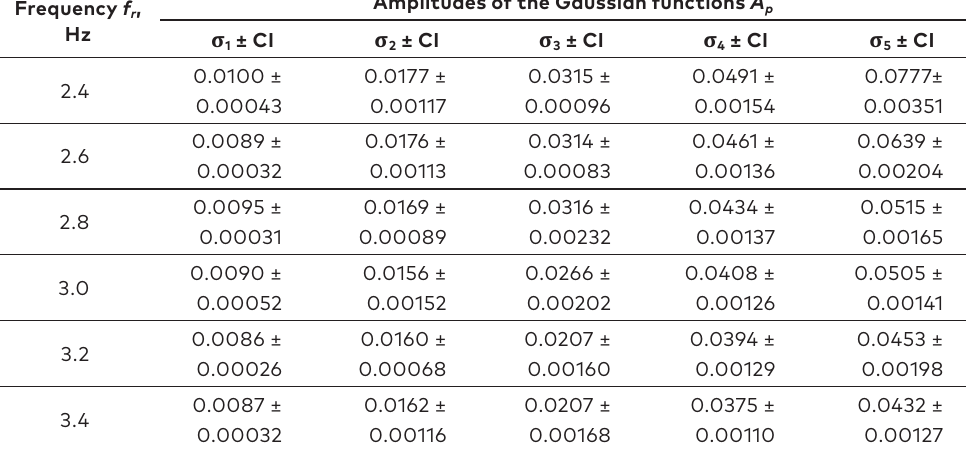
Table 12. Examples of σ p mean values and 95% confidence intervals (CI) determined for one heel-strike pattern runner in frequency range f r = 2.4–3.4 Hz (results of laboratory tests) Frequency f r ,